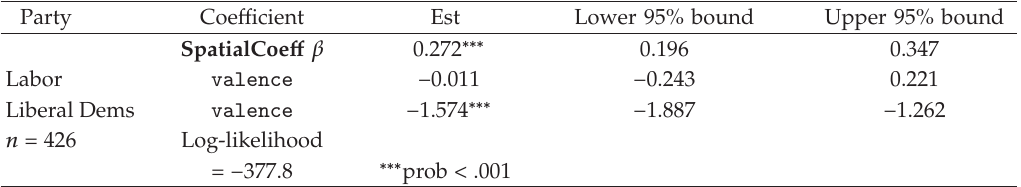
Table 10: British pure spatial model for 1979, with respect to the conservative